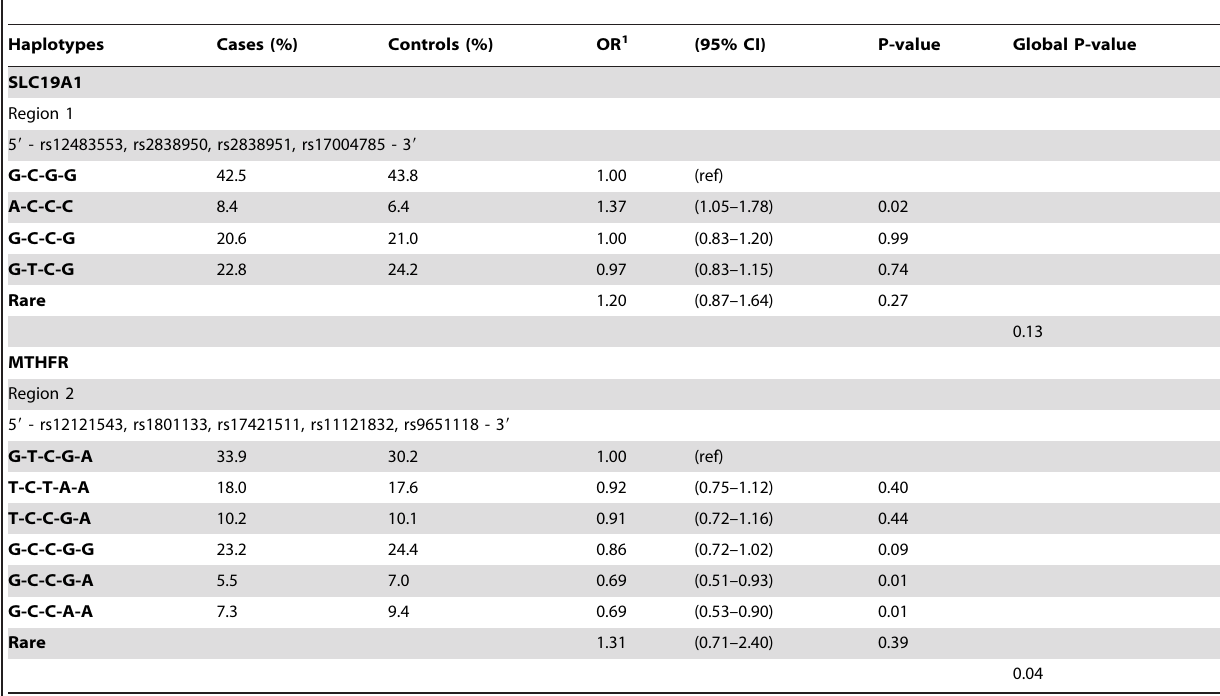
Table 3. Haplotypes in selected one-carbon metabolism genes and risk of renal cell carcinoma.